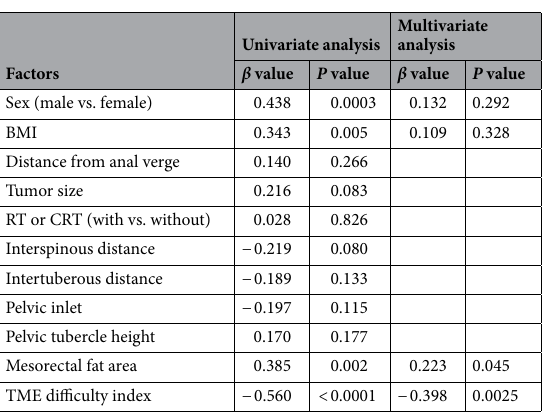
Table 3. Univariate and multivariate regression analyses for operative time for TME in all patients ( n = 65). TME total mesorectum excision, BMI body mass index, RT radiation therapy, CRT chemoradiotherapy.